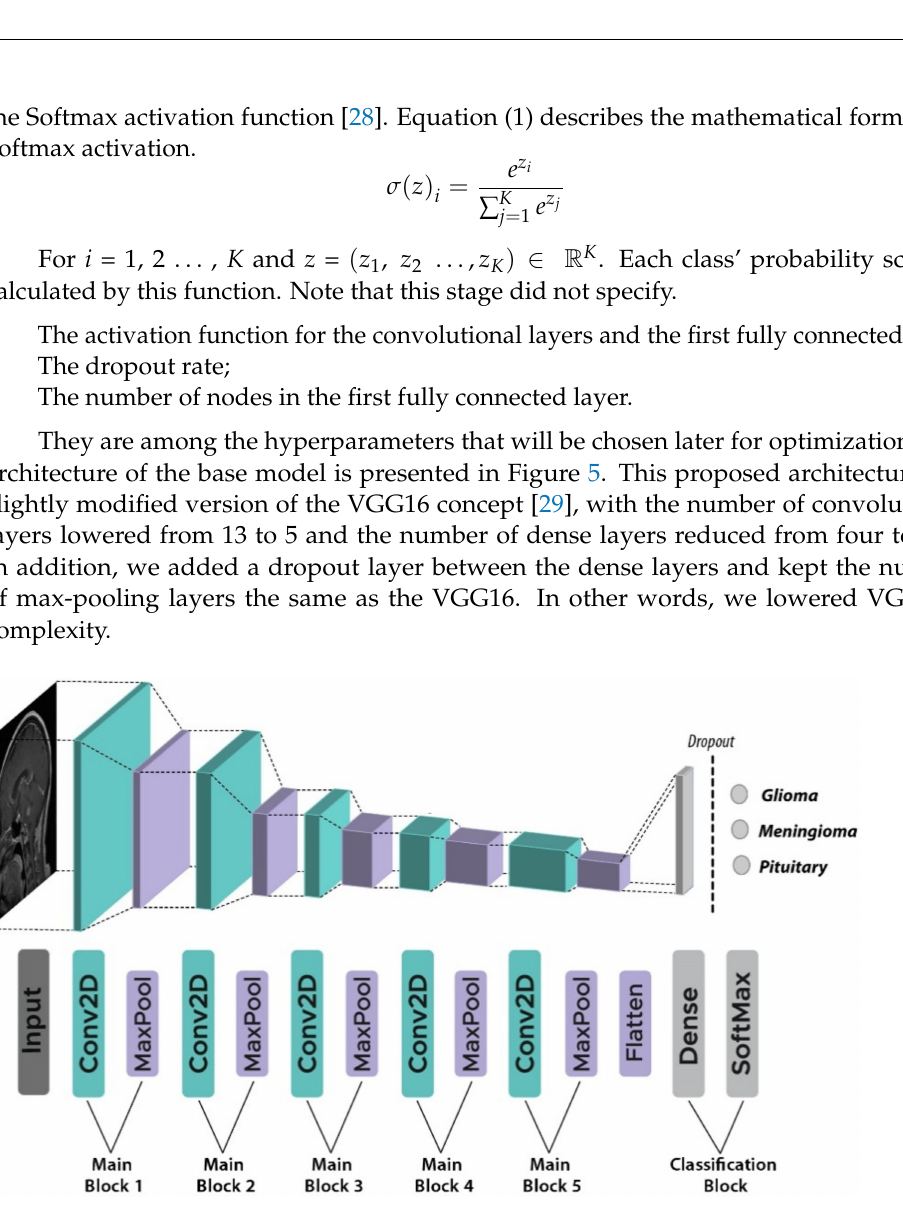
Figure 5. The architecture of the base model (five convolutional layers, five max-pooling layers, two fully connected layers and one dropout